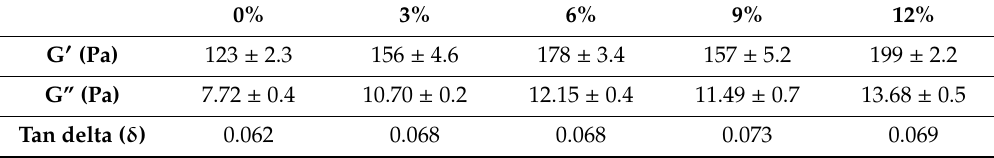
Figure 4. E ff ect of gum Cordia on the tan delta ( δ ) of corn starch gels. Figure 4. Effect of gum Cordia on the tan delta ( δ ) of corn starch gels. Table 6. Storage modulus G (cid:48) , Loss modulus G” and δ at 6.3 rad / s of corn starch-gum Table 6. Storage modulus G ′ , Loss modulus G ″ and δ at 6.3 rad/s of corn starch-gum blends.